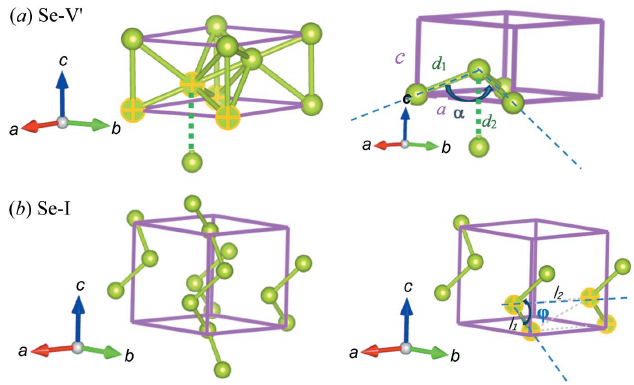
Figure 5 Schematic of geometrical interpretation of negative linear compressibility in the structures of ( a ) Se-V 0 and ( b ) Se-I.